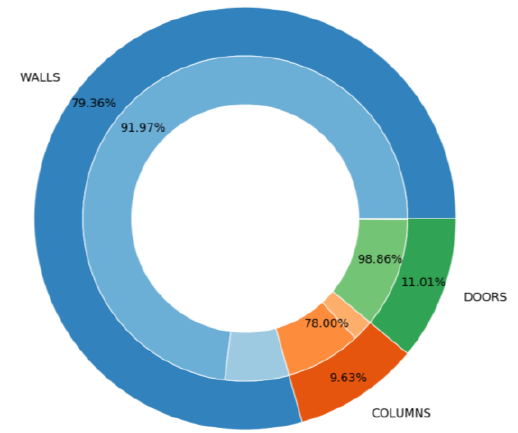
Figure 13. Statistics of point cloud acquisition by element